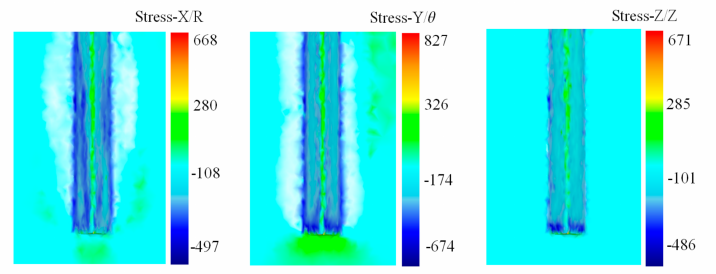
Figure 6. Tri-axial stress distribution during the stamping